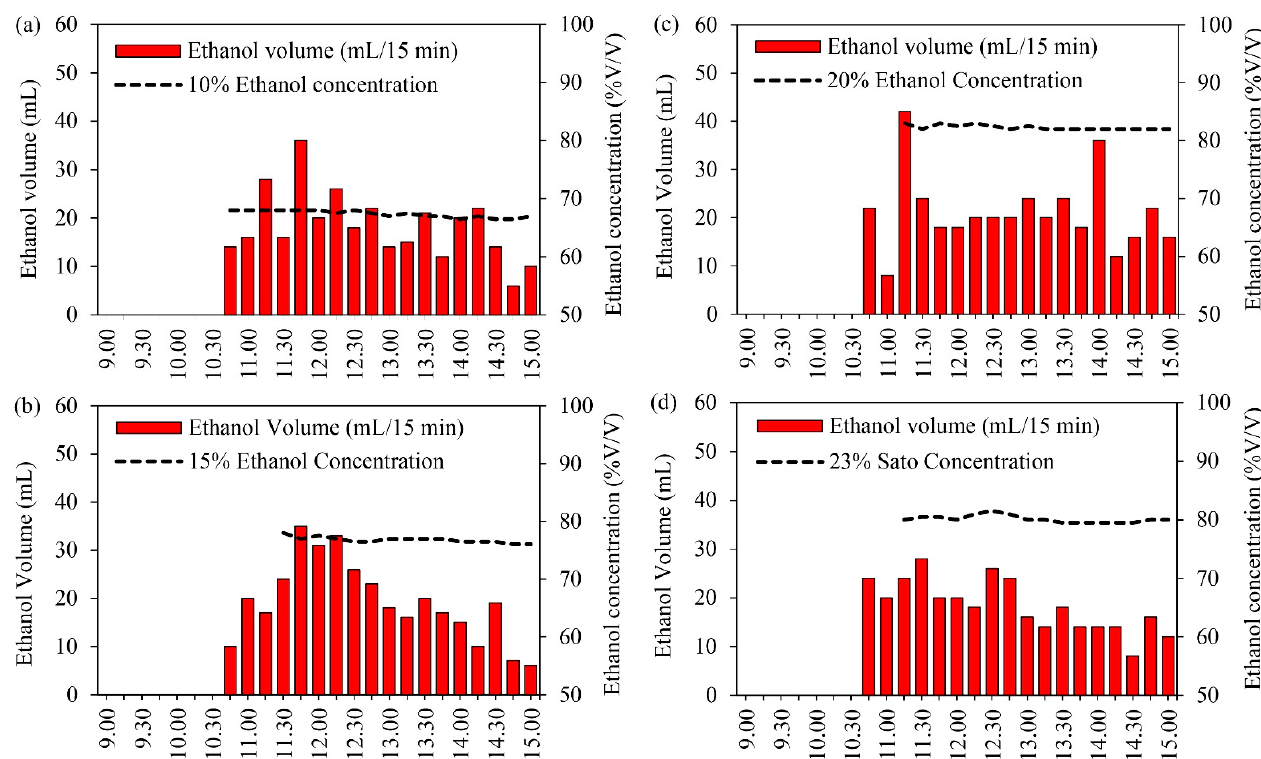
Figure 5. Ethanol volume and ethanol concentration at different solution concentrations: ( a ) 10% initial ethanol concentration, ( b ) 15% initial ethanol concentration, ( c ) 20% initial ethanol concentration, and ( d ) 23% initial Sato concentration.